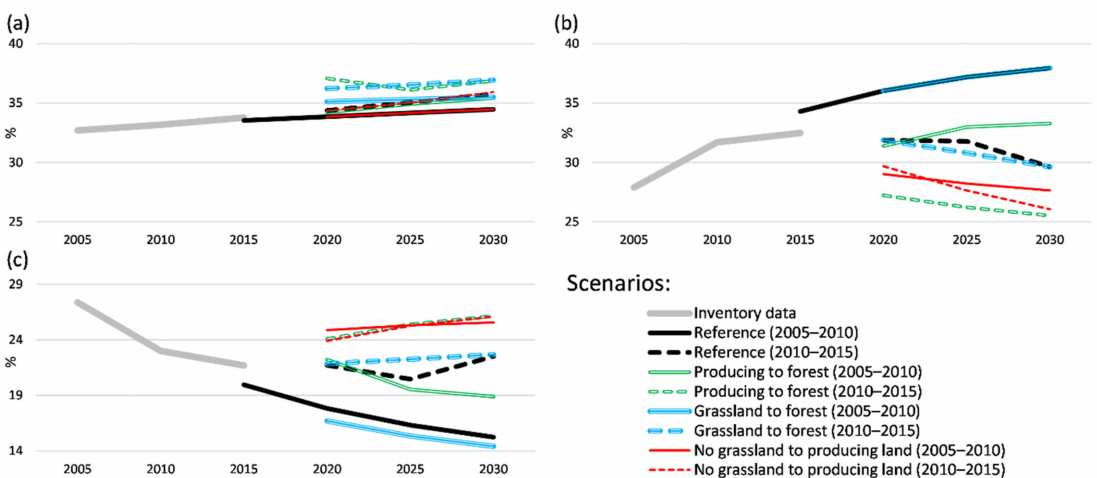
Figure 5. Projected development of selected land uses in Lithuania, depending on land use change scenarios: ( a ) forest land, ( b ) producing land, and ( c )